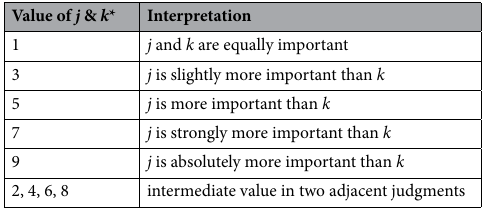
Table 1. Table of relative scores. * j & k not only mean the comparison between different nutritional indicators, but also the comparison between same indicators in different substrates.